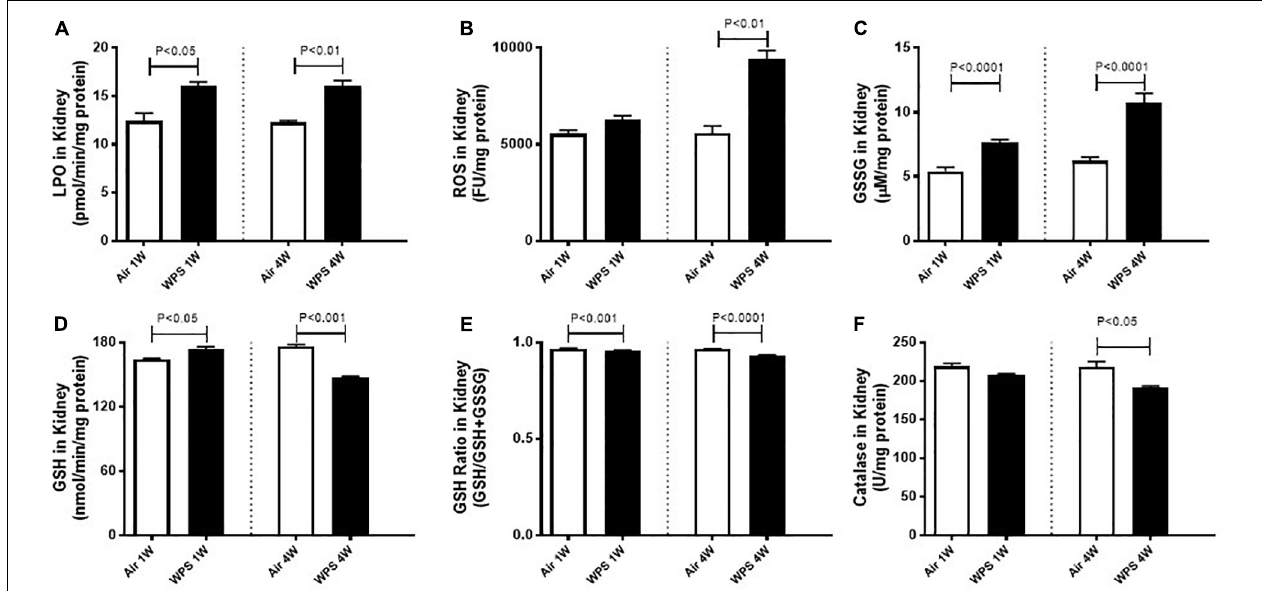
FIGURE 5 | Kidney homogenate levels of lipid peroxidation (LPO, A ), reactive oxygen species (ROS, B ), oxidized glutathione (GSSG, C ), reduced glutathione (GSH, D ), glutathione ratio (GSH/GSH+GSSG, E ), and catalase ( F ) in mice at the end of the 1-week and 4-week exposure periods to air (control) or water-pipe smoke (WPS). Data are mean ± SEM from three independent